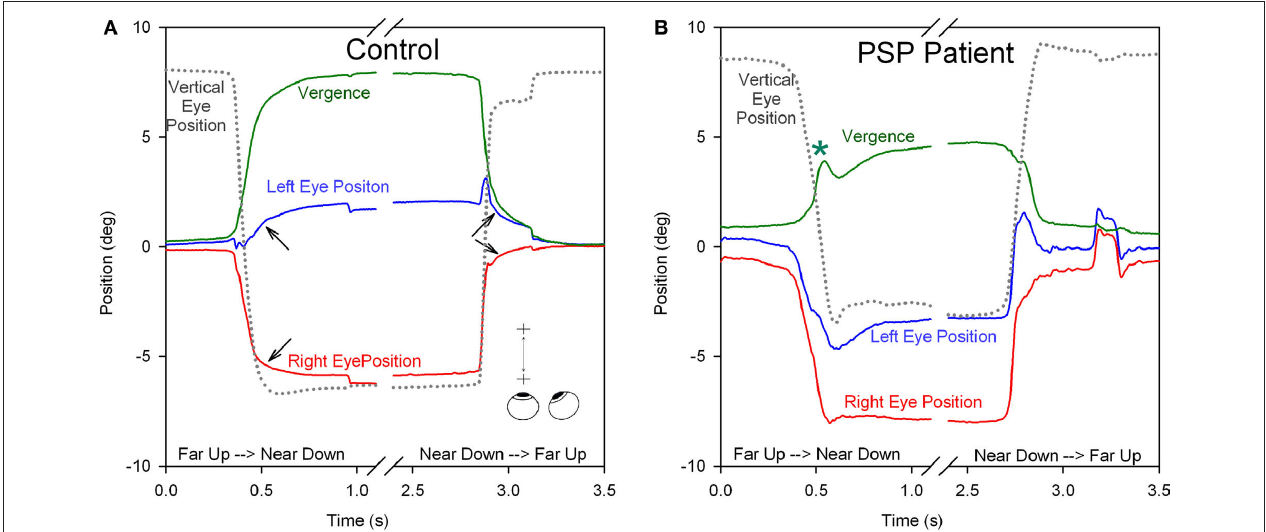
Figure 8 | Comparison of combined saccade–vergence responses as a control subject (A) or a patient with early PSP (B) attempted to make shifts of the point of fixation between two visual targets aligned on the left eye (Müller paradigm), one located at far and one at near [see inset in (A)]; the far target was higher than the near target, requiring an associated vertical saccade. The normal subject uses disjunctive saccades (right movement bigger than left) followed by a vergence movement (arrows)